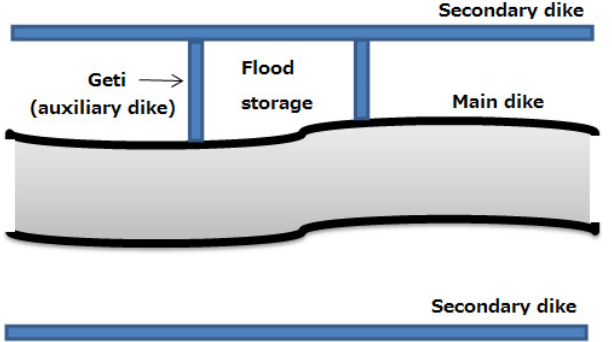
Figure 1. Practice of flood storage creation with levees in ancient